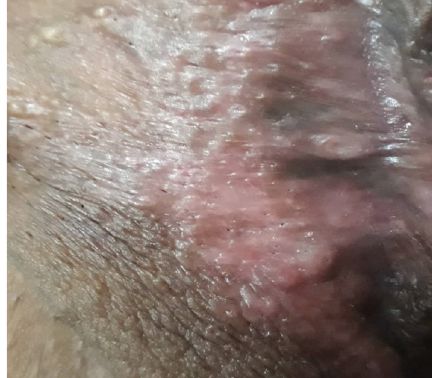
Figure 4: Remission after treatment by